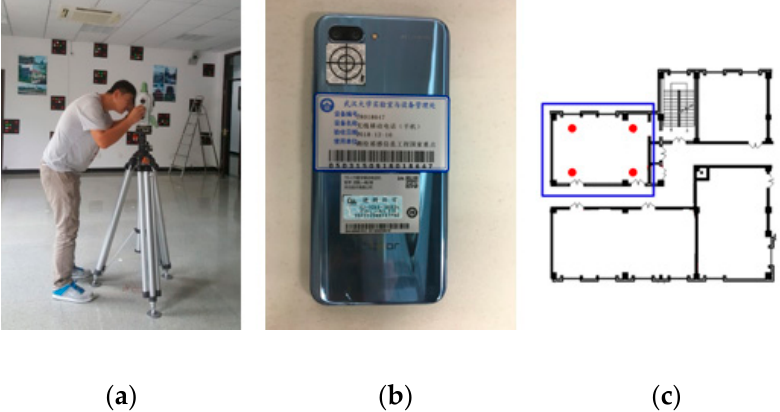
Figure 10. Experimental equipment and environment. ( a ) Leica TS60 measurement robot. ( b ) Ring crosshair on smartphone. ( c ) Control crosshair on smartphone. ( c ) Control point.